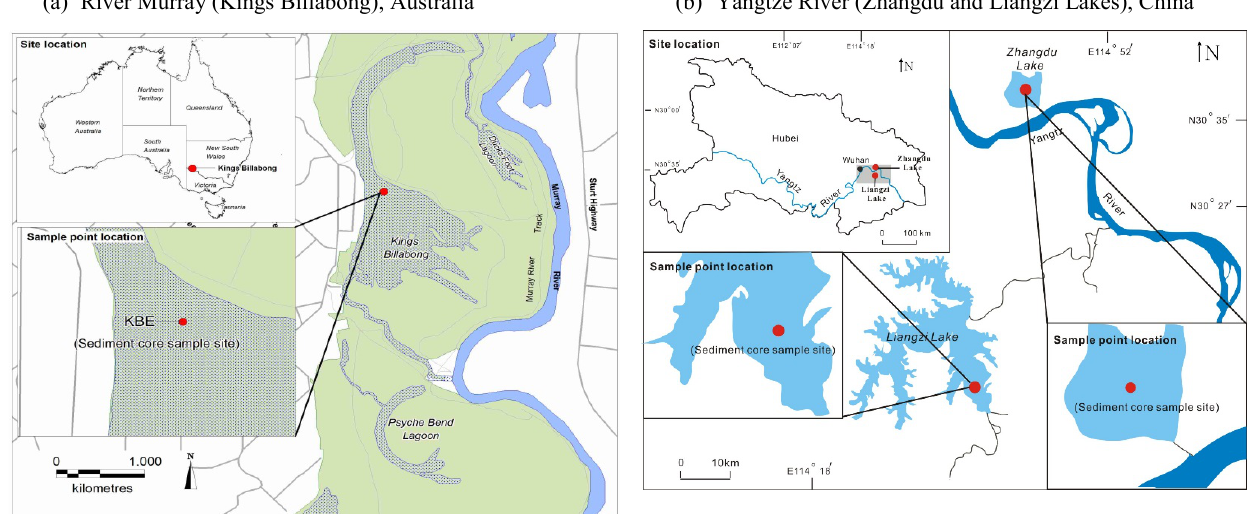
Figure 1. Study areas in Australia and China. (a) Kings Billabong, one of the wetland complexes of the River Murray system in southeast Australia and (b) Zhangdu and Liangzi lake wetland complex around the middle reaches of the Yangtze River in the Hubei Province of China. The red dots are coring locations for this